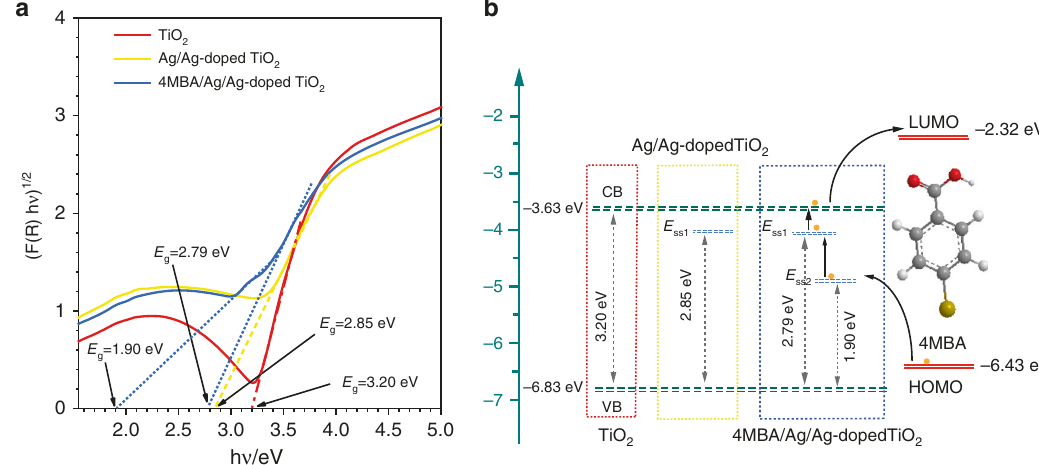
Fig. 6 Diagram of energy levels. a Curves of (F(R) h ν ) 1/2 vs. h ν for TiO 2 , Ag/Ag-doped TiO 2 substrate and 4MBA/Ag/Ag-doped TiO 2 hybrid system, respectively. b Schematic diagram illustrating the photo-induced CT between the Ag/Ag-doped TiO 2 substrate and 4MBA molecule under the excitation of 785-nm